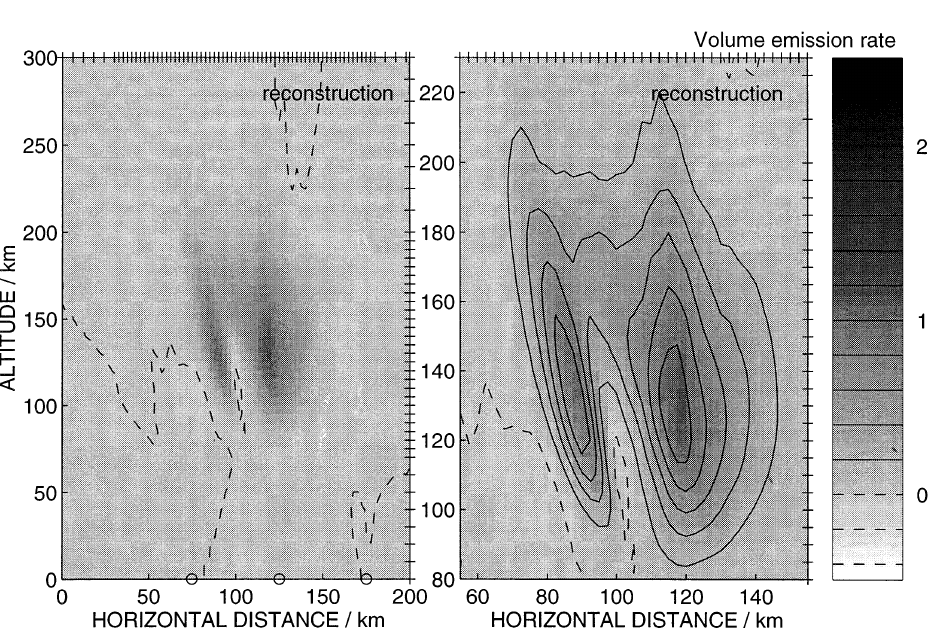
Fig. 5. Same as Fig. 4 for three receivers at 50, 100 and 150 km